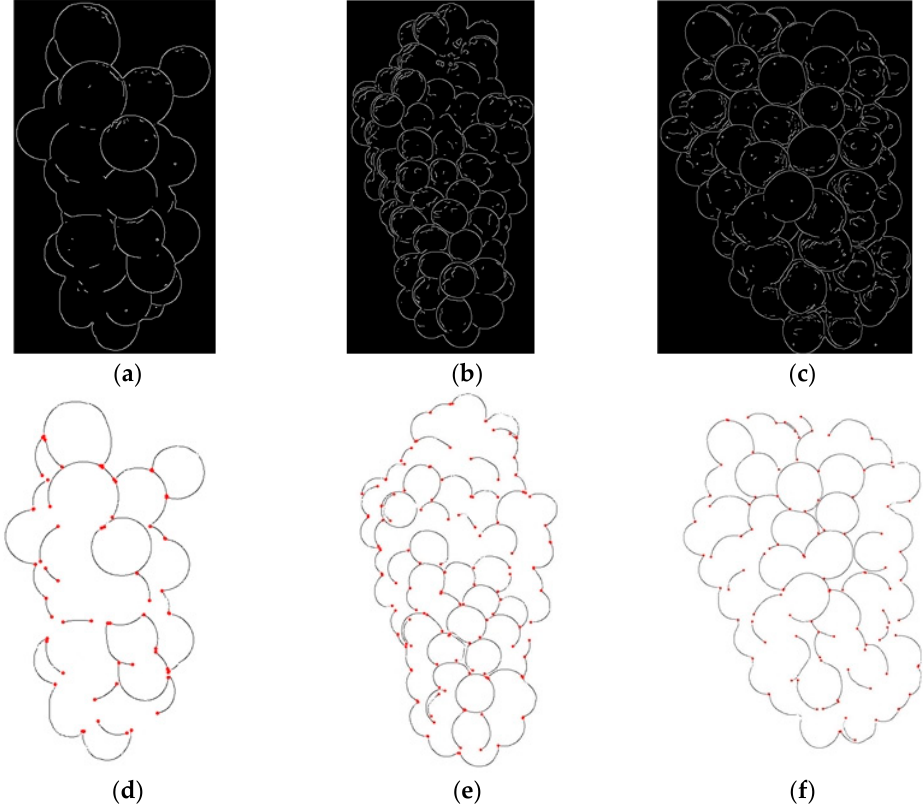
Figure 9. Different types of grape berry contour segment differentiation graph. ( a ) is a binary map of red grapes, ( d ) is a detection map of red grapes contour pits, ( b ) is a binary map of purple-black grapes, and ( e ) is a pit detection map of purple-black grapes. ( c ) is the binary map of green grapes, ( f ) is the detection map of the contour pits of the green grapes, and the red dots represent the final pits of the contour segment of the